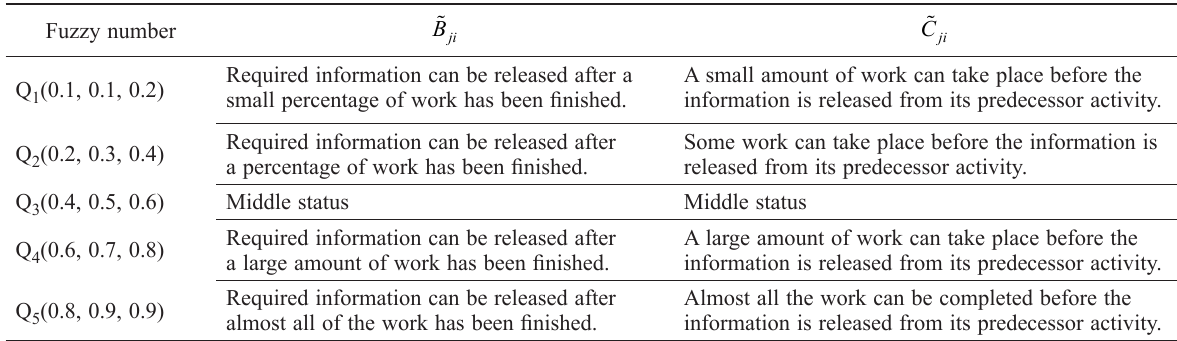
Table 1. Description of linguistic